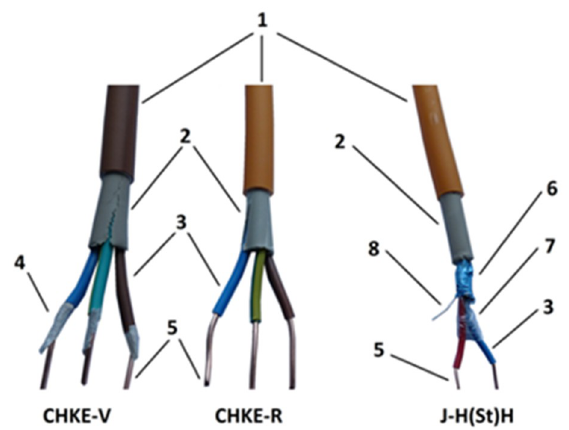
Figure 1. Examined cable samples: ( 1 ) Outer sheath, ( 2 ) Bedding, ( 3 ) Insulation, ( 4 ) Mica tape, ( 5 ) Copper wire, ( 6 ) Aluminum foil, ( 7 ) Polyethylene terephthalate foil, ( 8 ) Drain wire.